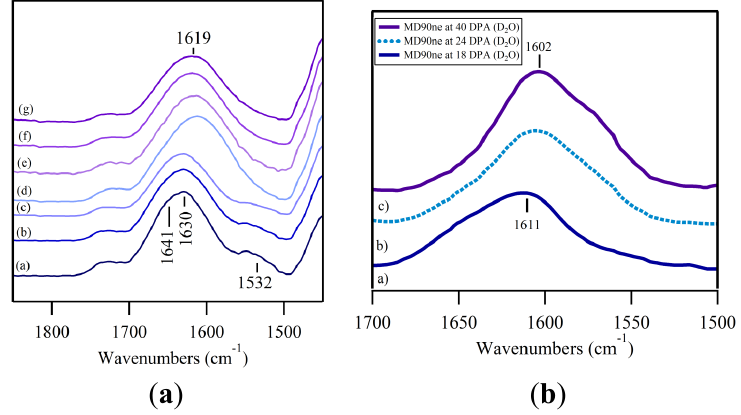
Figure 3. ( a ) FTIR spectra of the O-H bending region for cotton fibers harvested at different DPA: (a) 18 DPA; (b) 20 DPA; ( c ) 24 DPA; (d) 28 DPA; (e) 32 DPA; (f) 36 DPA; and (g) 40 DPA; ( b ) O–H bending region (deuterated) harvested at 18 DPA (bottom), 24 DPA (middle), and 40 DPA (top).